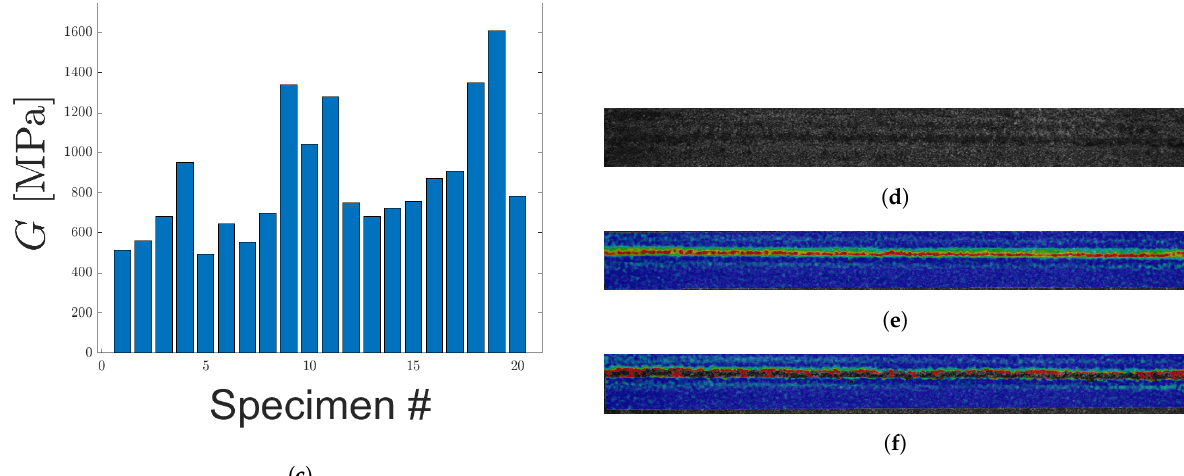
Figure 15. The engineering stress–strain response for LC 3 (out of plane shear) is presented in ( a ), with maximum stress and strain marked with black and red, respectively. In ( b , c ) maximum stress and equivalent shear modulus are presented. ( d ) contains the speckle pattern for one of the specimens. In ( e , f ), the strain field along the loading direction (before and after fracture), obtained using DIC, is presented.